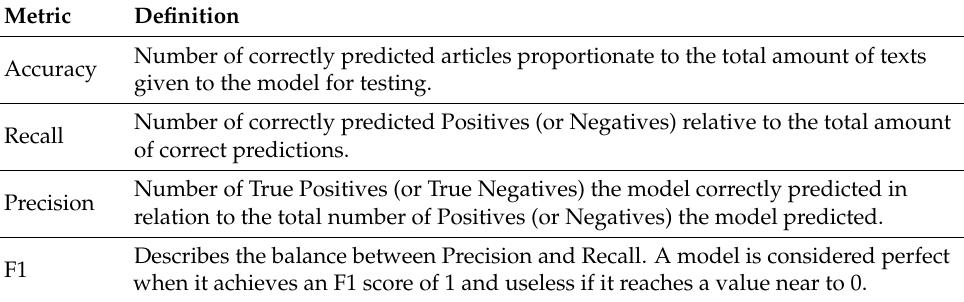
Table 2. Common Evaluation